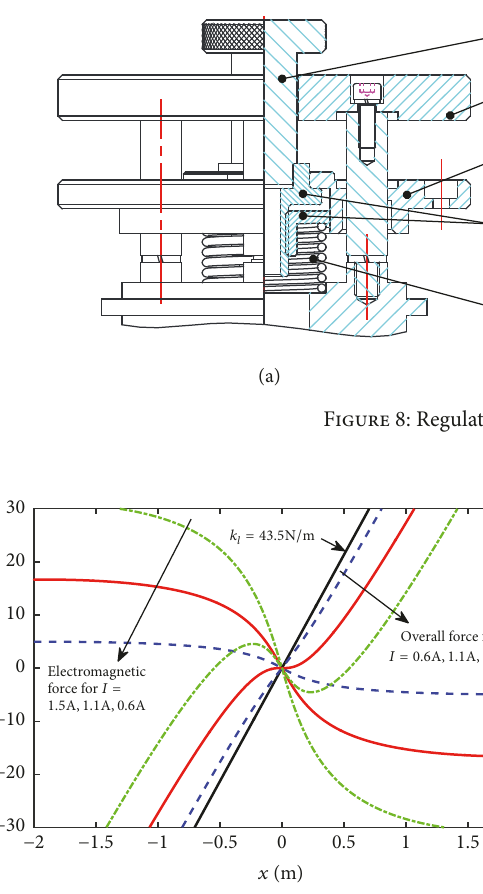
Figure 9: Force and displacement curves of the EATS for various